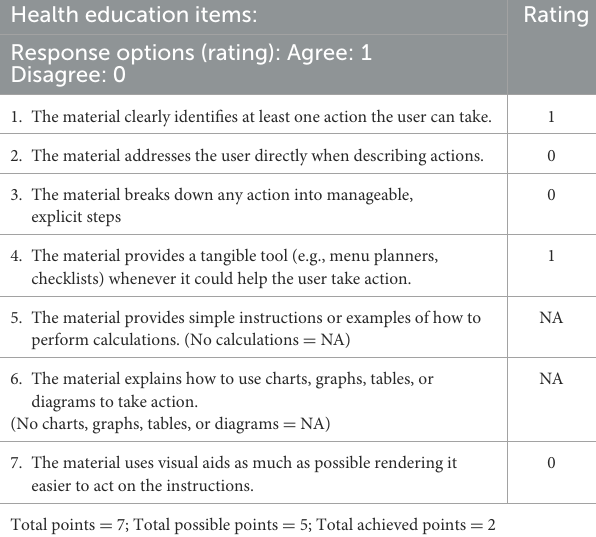
TABLE 1B Assessment of printed patient education materials provided to caregivers in CSPM (using PEMAT-P): actionability. Health education